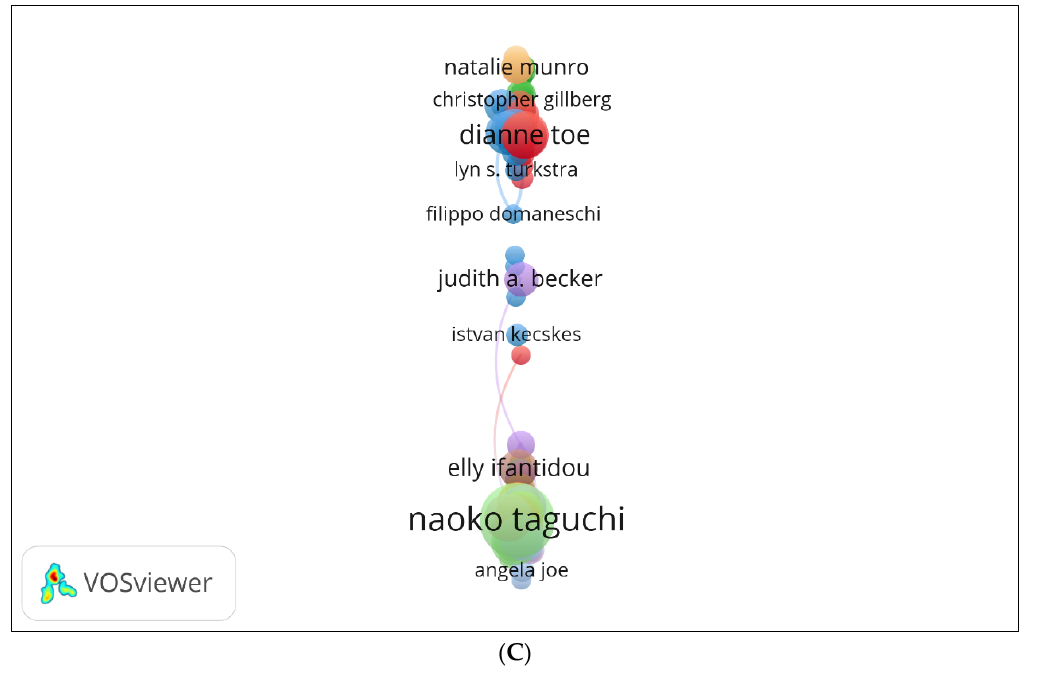
Figure 11. Network visualisation of author (co)-citation: ( A ) Scopus; ( B ) WOS; ( C ) Lens—citation.